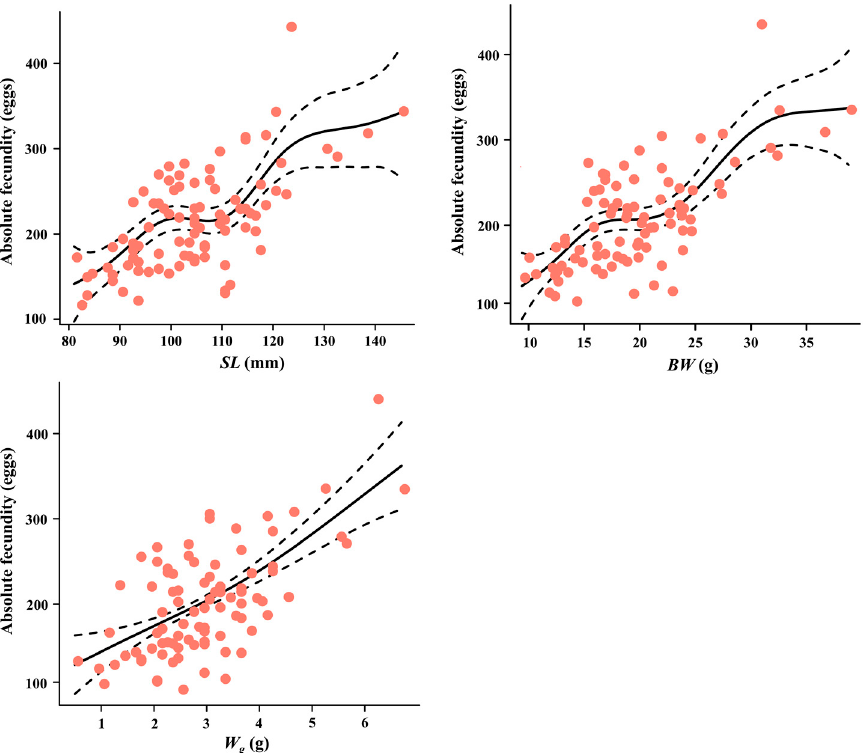
Figure 8. Generalized additive model (GAM) explaining the relationships between standard length ( SL ), body weight ( BW ), gonad weight ( W g ), and absolute fecundity of Garra tibetana . Solid lines represent the estimated smooth function, and the dotted lines represent the 95% confidence interval.